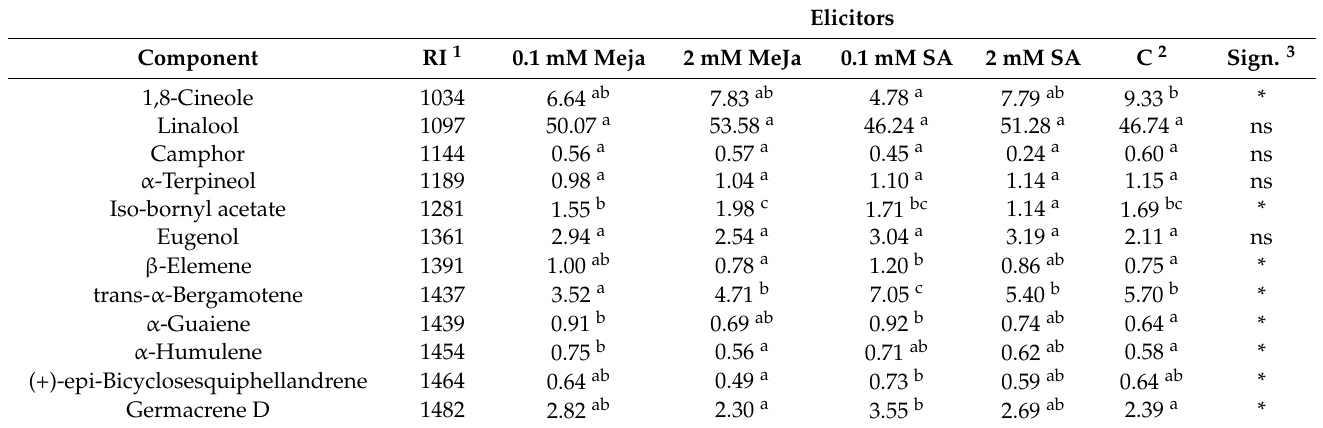
Table 7. The chemical composition of the EO of